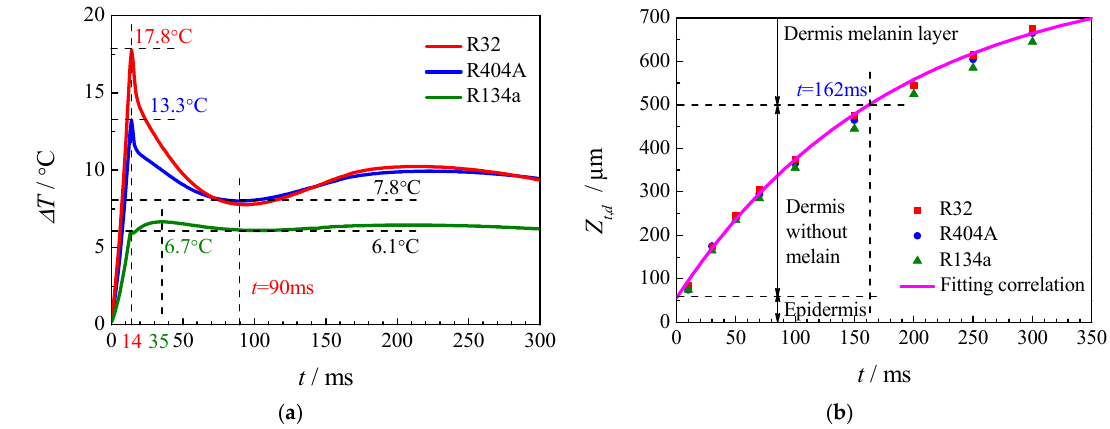
Figure 17. Time-varied ( a ) radial surface temperature difference and ( b ) axial cooling depth during CSC.